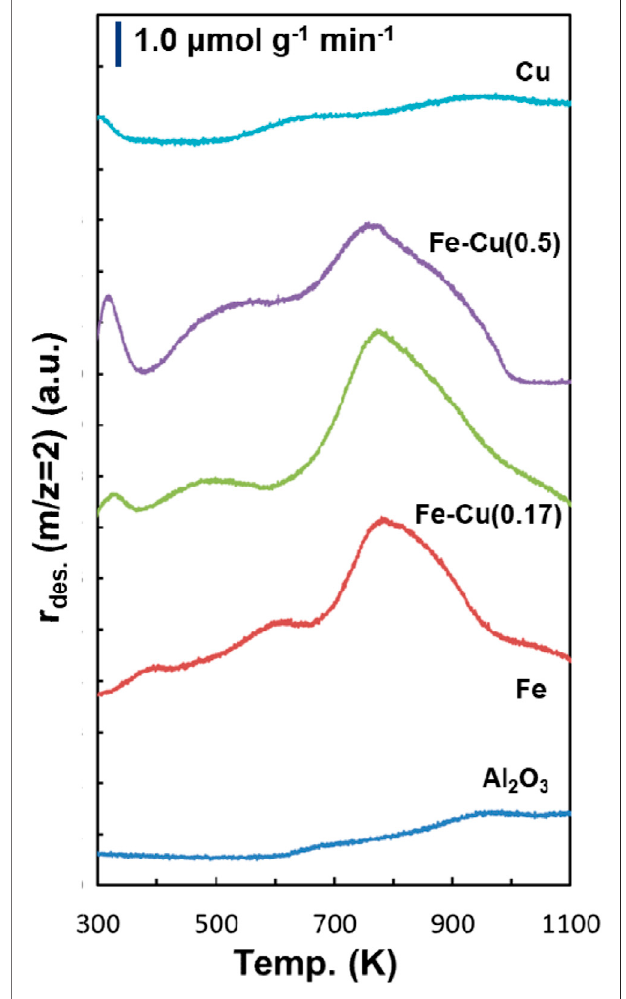
FIGURE 7 | H 2 -TPD pro fi les of the Fe/Al 2 O 3 , Fe-Cu(X)/Al 2 O 3 and Cu/ Al 2 O 3 catalysts and Al 2 O 3